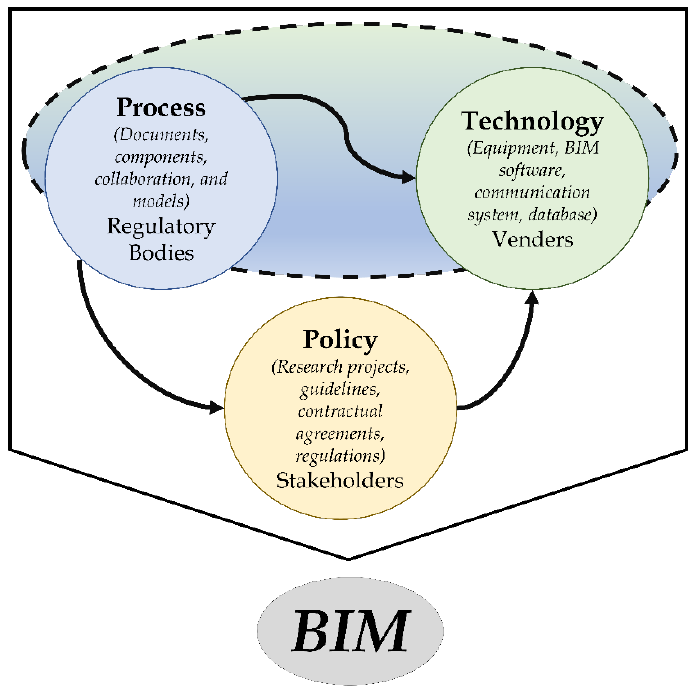
Figure 2. The three main fields in BIM [48].